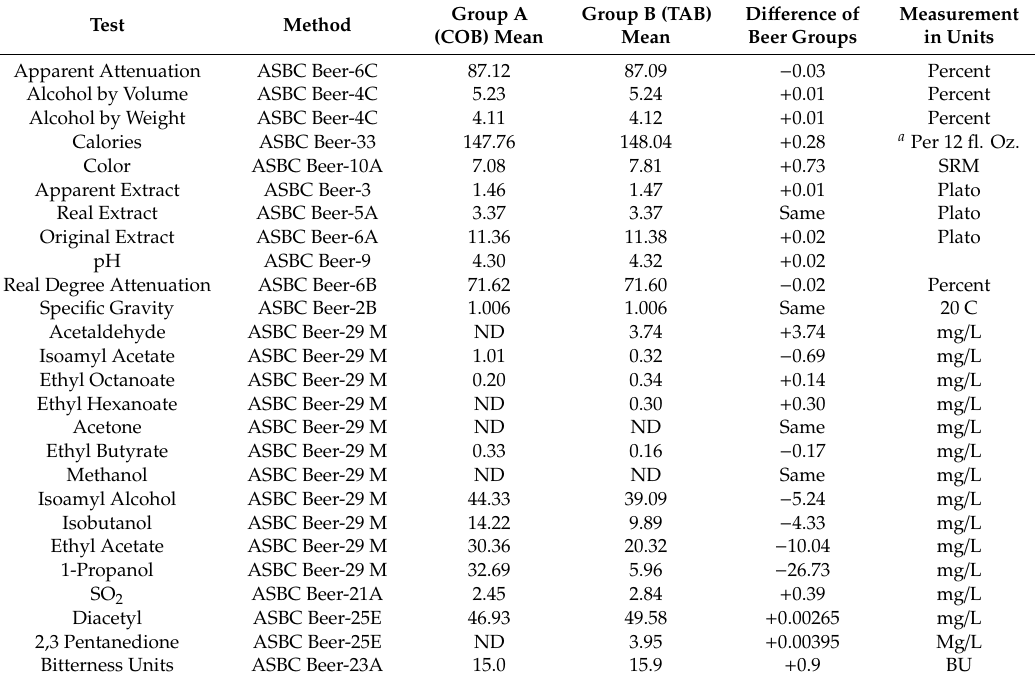
Table 5. Chemical Analysis